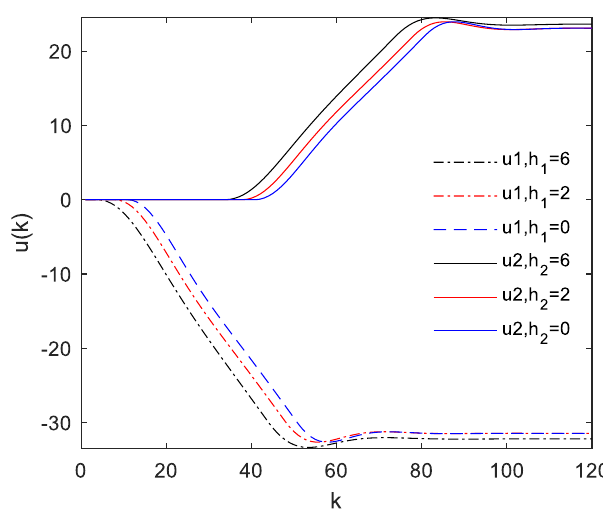
θ = 1, θ = 0, control input of system (1) with di ff erent M 2 1